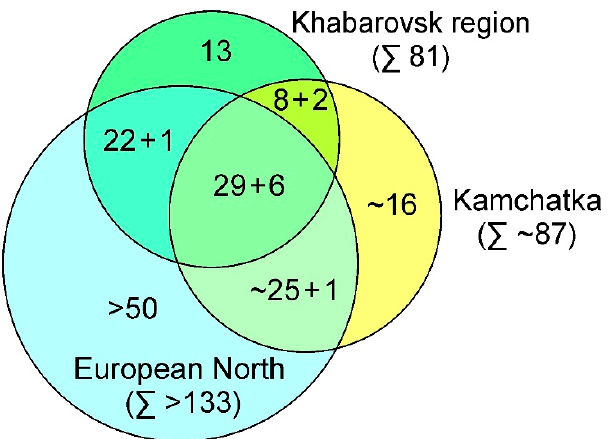
Figure 7. Similarity of the Khabarovsk region, the European North and Kamchatka aapa mire floras. ”+” shows the number of vicarious (close) species. The data on the aapa mires flora of Kamchatka are approximate [data from 20,23,32,57]. The data on the aapa mires of the European North is approximate and based on personal observations.